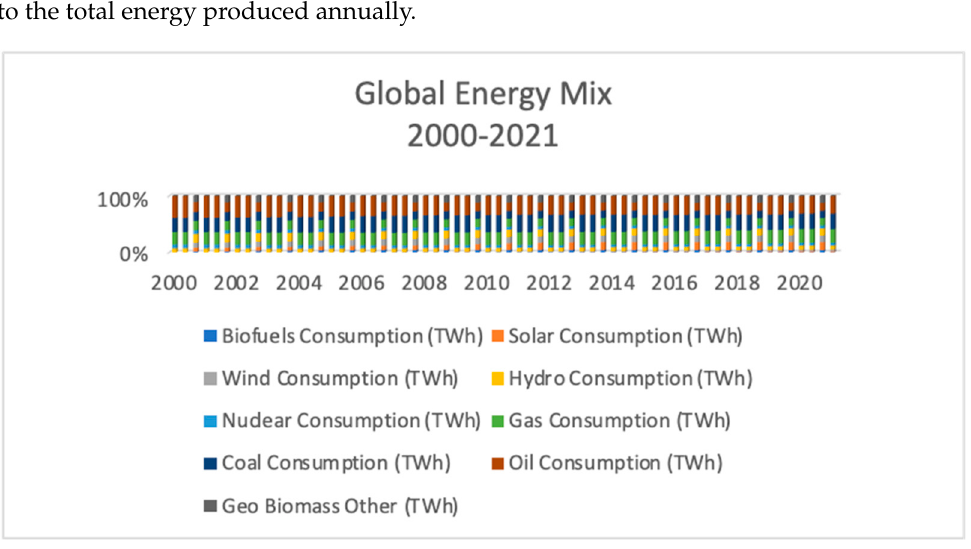
Figure 3. Global Energy Mix (2000–2021). Constructed by the authors.